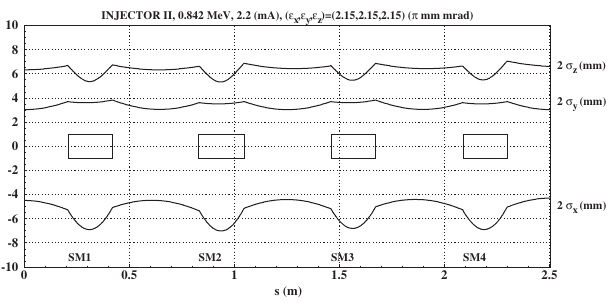
FIG. 1. Transport (re)computation of a matched beam in injector II for a circulating beam of 2.2 mA at low energy. The boxes indicate the position of the sector magnets SM1–SM4. The horizontal beam width is plotted as a negative value. The longitudinal beam size is plotted as 2 (cid:8) z